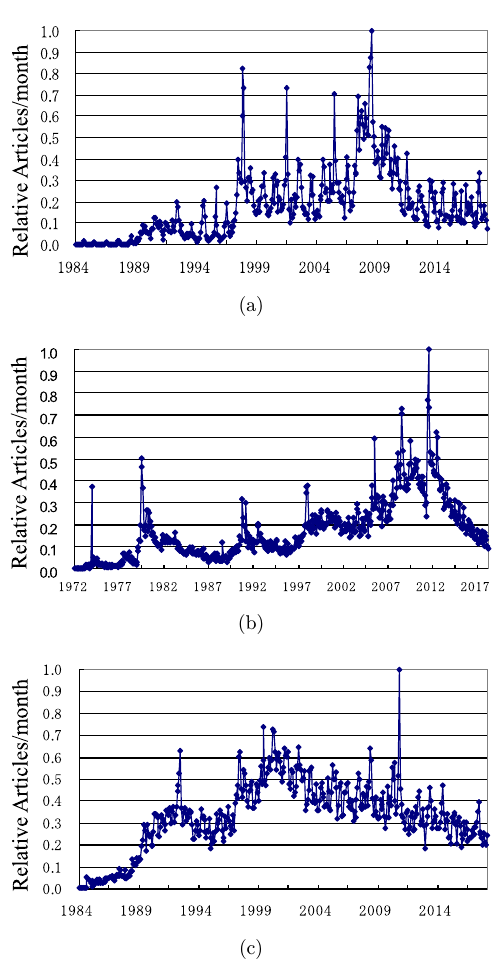
Fig. 2. Secular variation of the number of articles appeared in Japanese newspapers on (a) the global warming, (b) the energy saving and (c) nature. The maximum values of the variable are 349.6, 228.3 and 390.0 articles/month for the cases (a), (b) and (c), respectively, which are all normalized to 1.0 in these